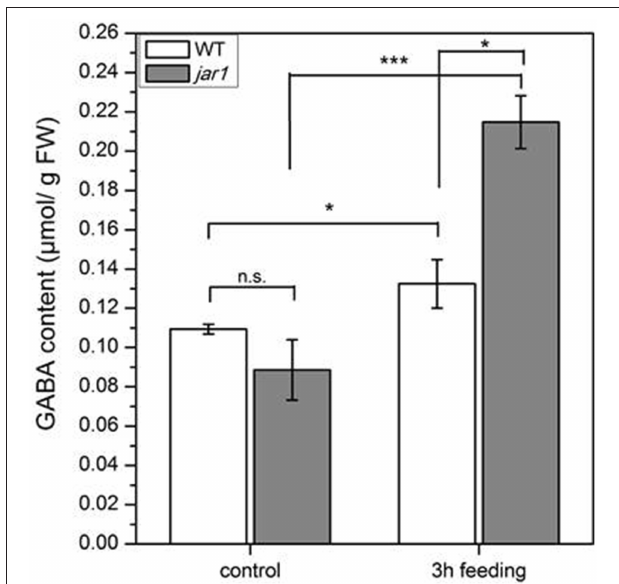
FIGURE 9 | Accumulation of GABA after S. littoralis feeding in wild-type (WT) and jar1 plants. Mean ( ± SE, n = 6 ) levels of GABA were determined after a feeding period of 3h. Hormone and GABA levels were measured only from local S. littoralis- fed leaves. Untreated leaves from untreated plants were used as controls. Statistically significant differences between the treatments were analyzed by t -test, * P ≤ 0.05, *** P ≤